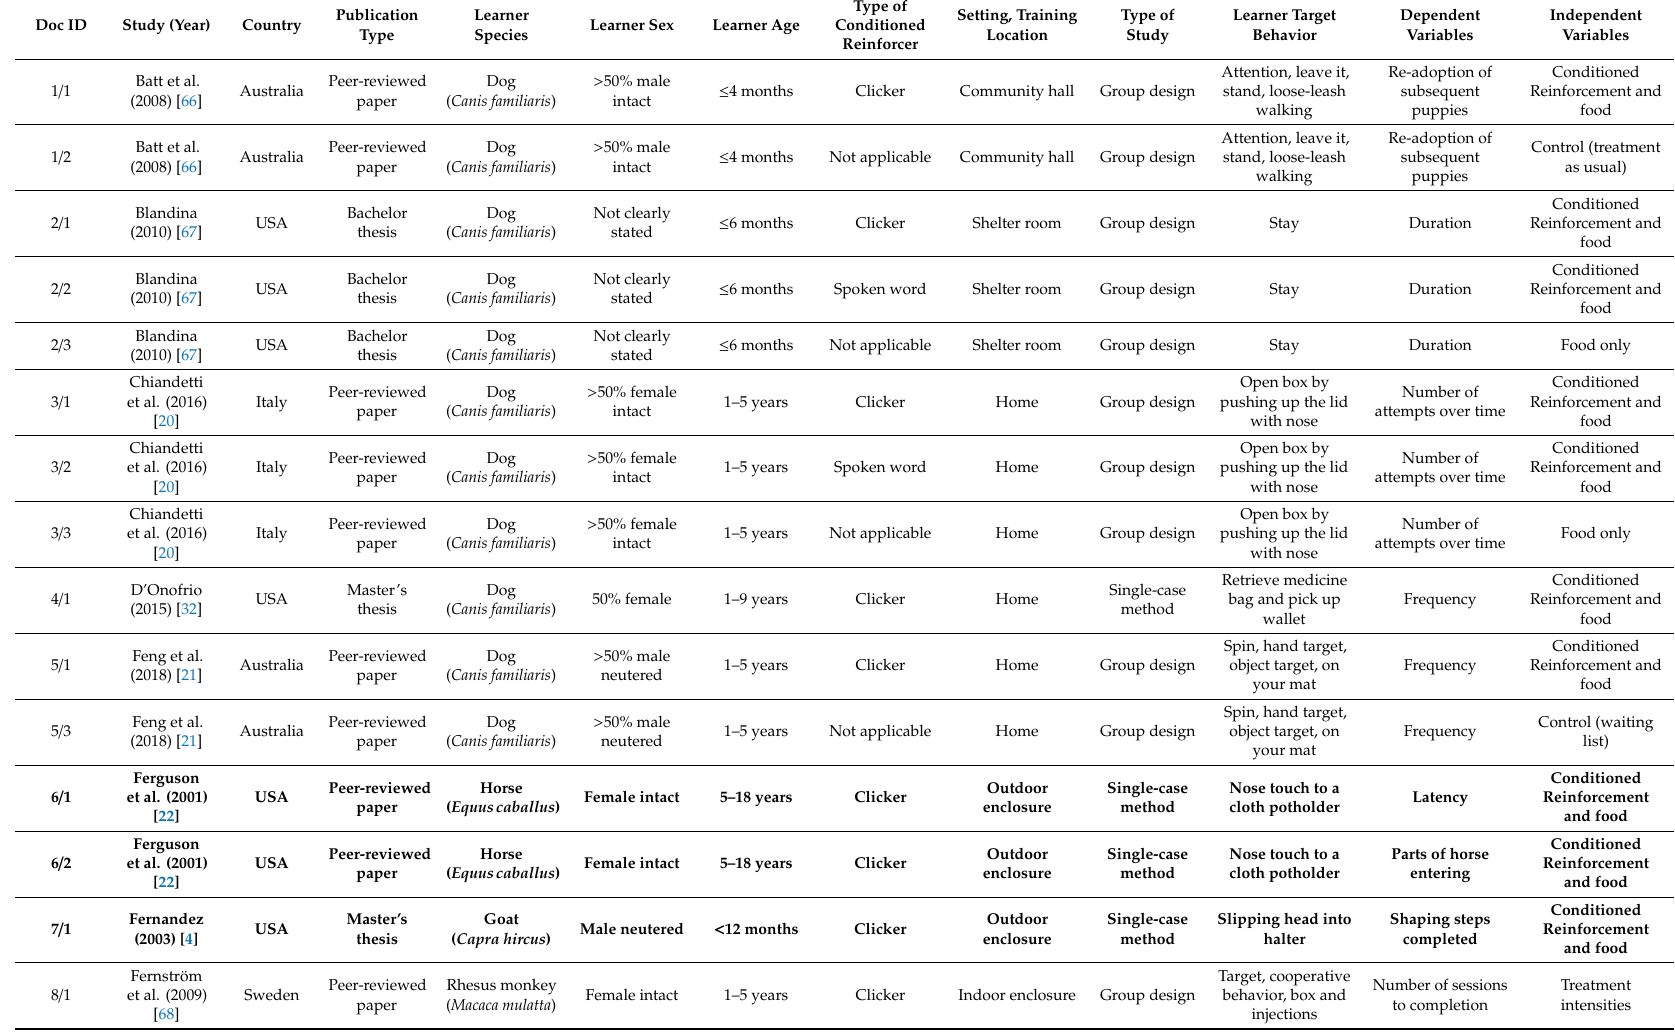
Table 2. Characteristics of all eligible